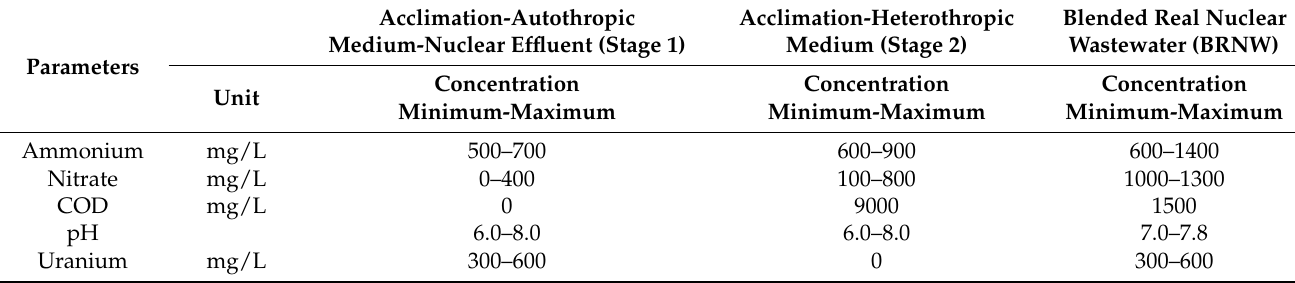
Table 1. Characteristics of the acclimatation media for bacterial